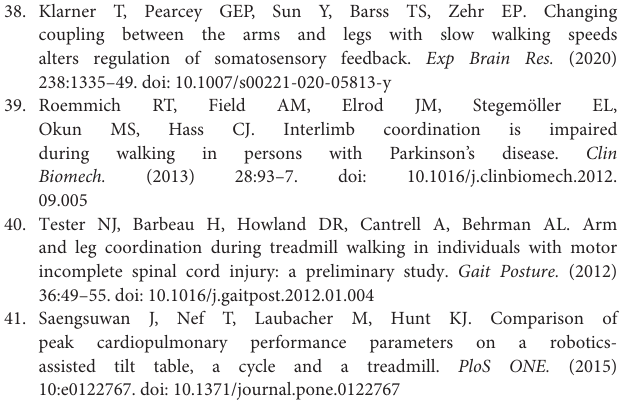
assisted tilt table, a cycle and a treadmill. PloS ONE. (2015) 10:e0122767. doi: